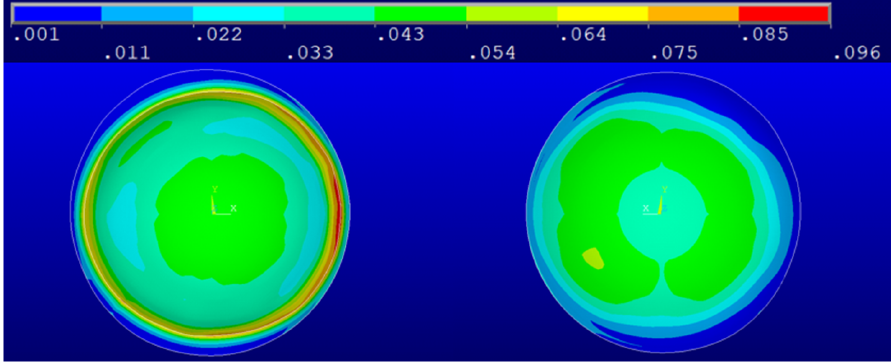
Figure 9. Von Mises Strain distribution in measurement phase for G1 geometry.